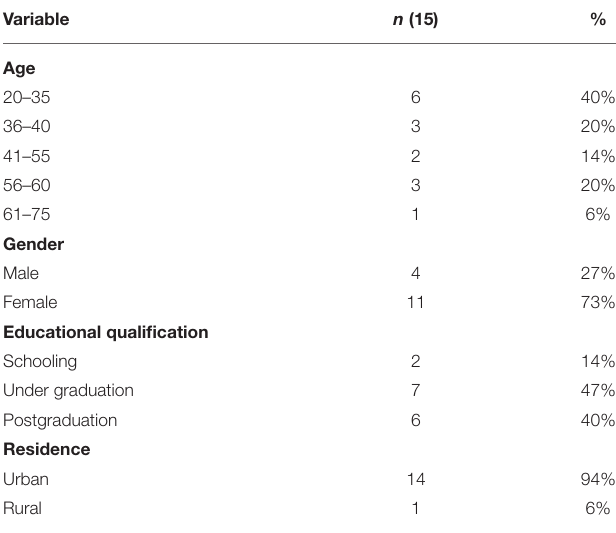
TABLE 1 | Sociodemographic characteristics of the